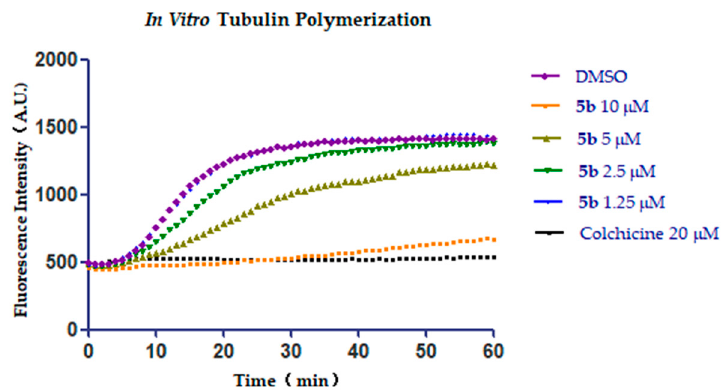
Figure 2. Effect of 5b on tubulin polymerization in vitro. Purified tubulin protein at 2 mg/mL in a reaction buffer was incubated at 37 ◦ C in the presence of 1% dimethyl sulfoxide (DMSO), test compound 5b at 1.25, 2.5, 5, or 10 µ M or colchicine at 20 µ M. The fluorescence intensity was measured every 60 s for 60 min and is presented as increases in the polymerized microtubule.